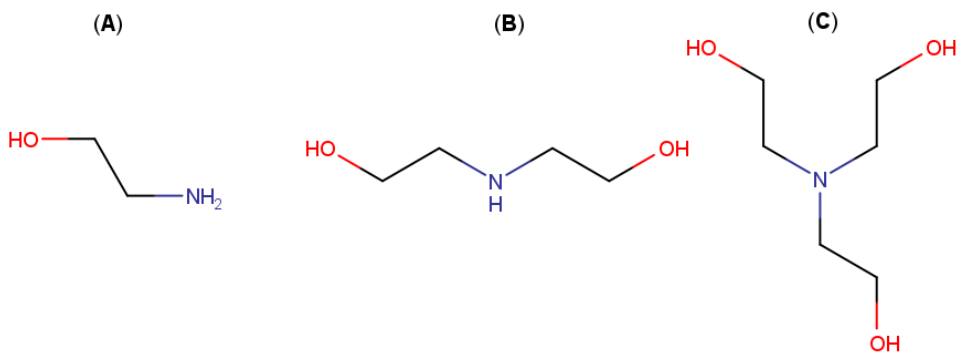
Figure 6. Molecular structures of: ( A ) monoethanolamine, ( B ) diethanolamine and ( C ) triethanola- mine.